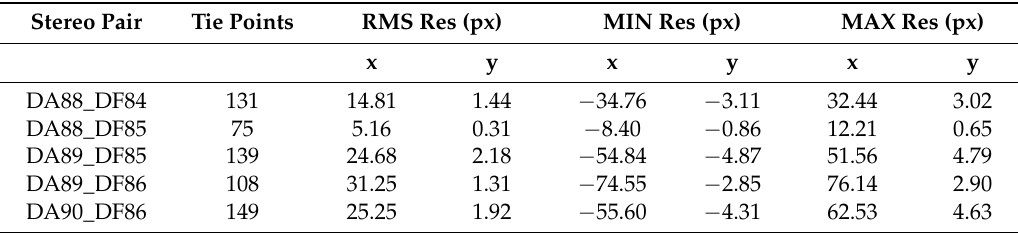
Table 4. Geometric parameter adjustment results for relative orientation. x, parallax across flight direction; y, parallax in flight direction.